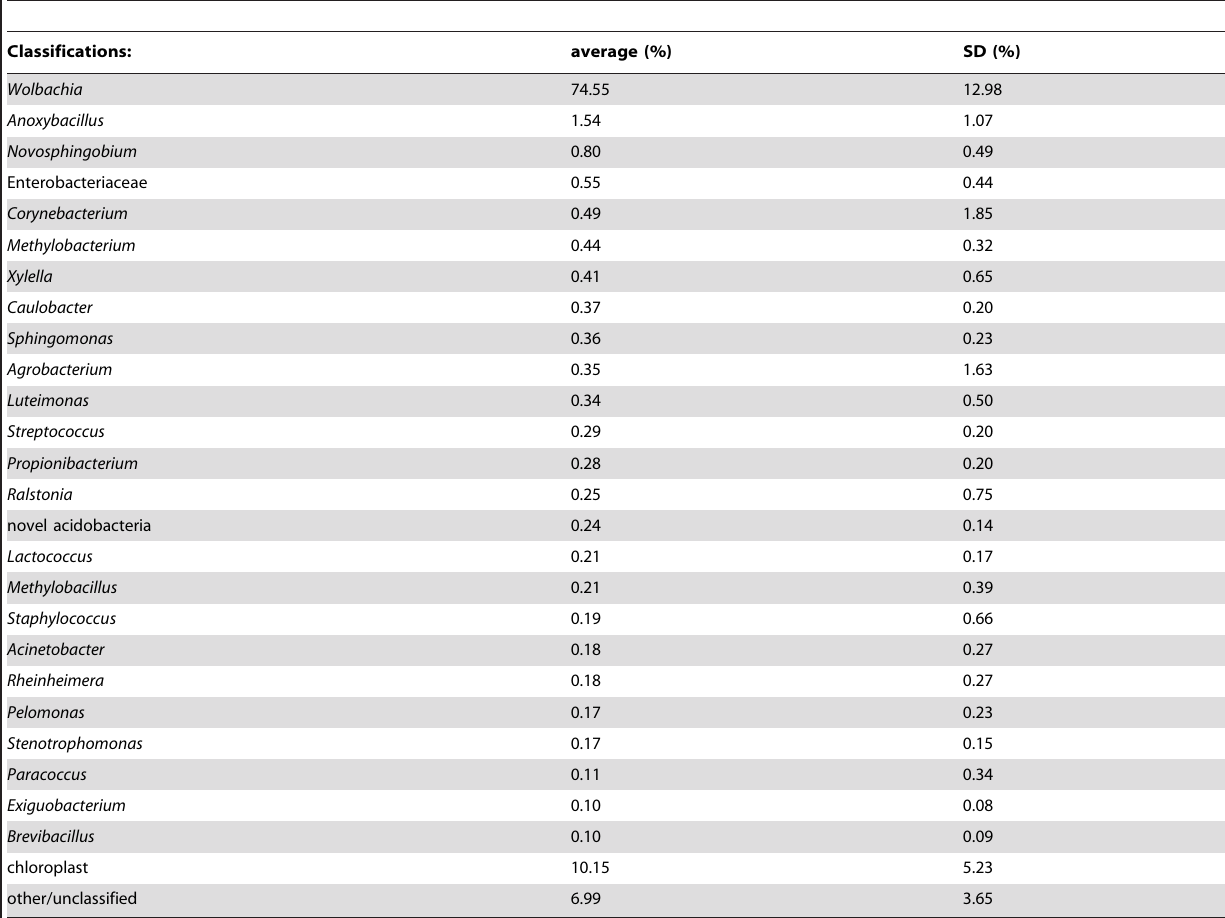
Table 2. Bacterial Genera